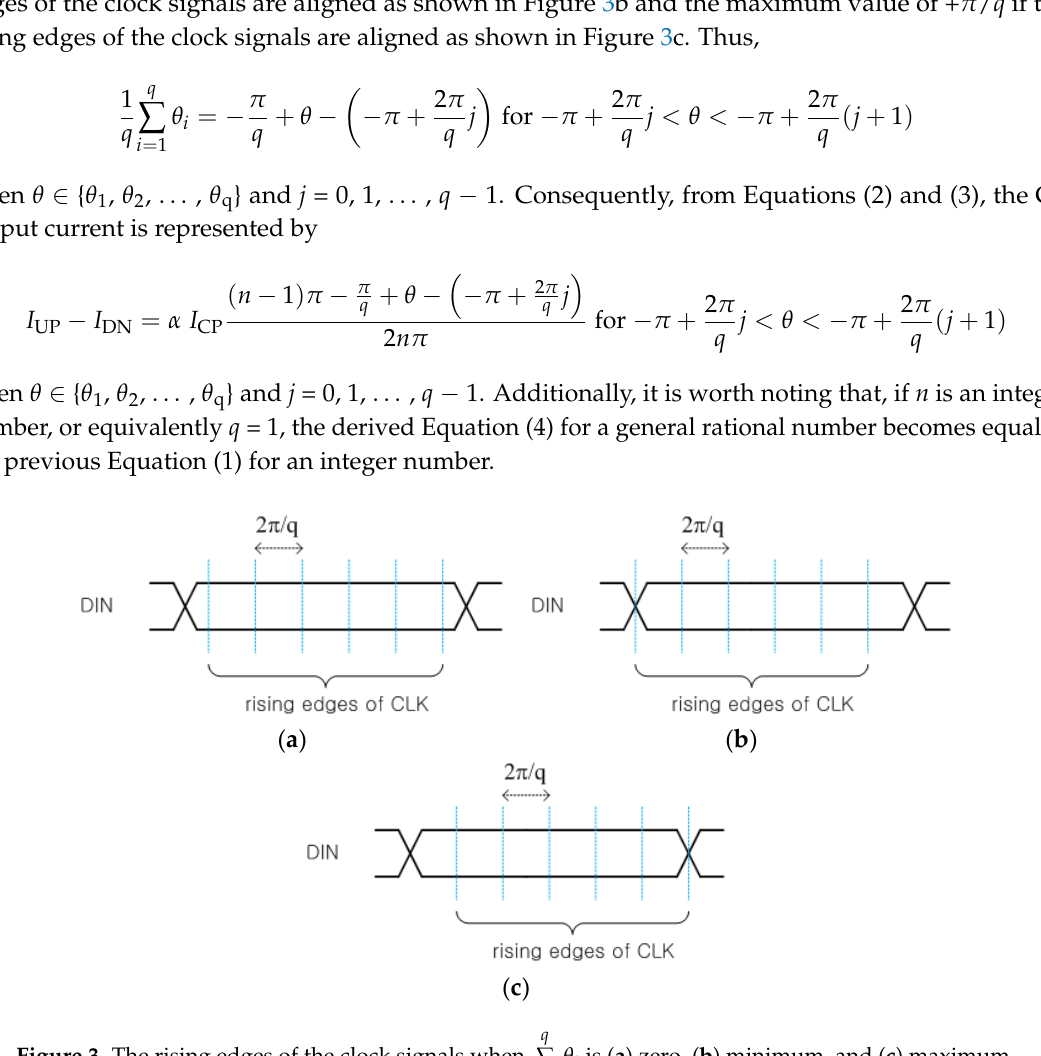
q q ∑  is ( a ) zero, ( b ) minimum, and ( c ) θ i is ( a ) zero, ( b ) minimum, and ( c ) i i = 1  i 1